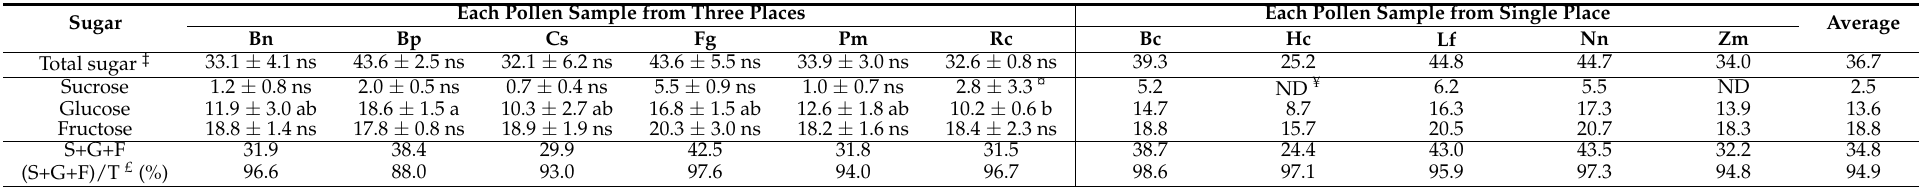
Table 3. Sugar composition of bee pollen samples (g/100 g dry mass) †